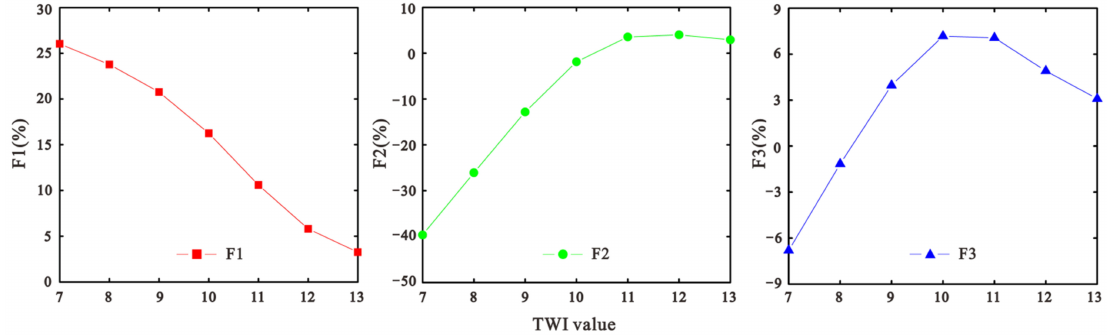
Figure 5. The three types of indicators: F1, F2 and F3 as a function of the TWI value.